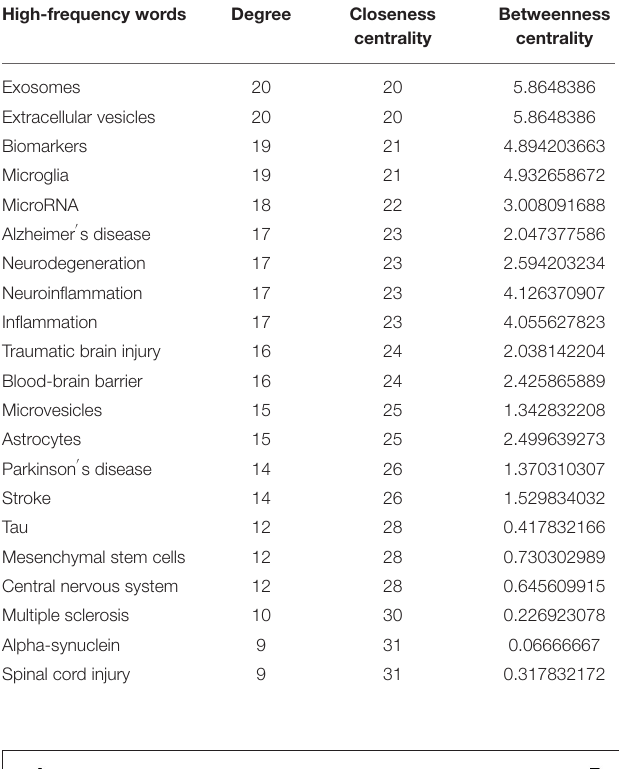
TABLE 3 | Social network parameters of 21 high-frequency words (ranked by degree).